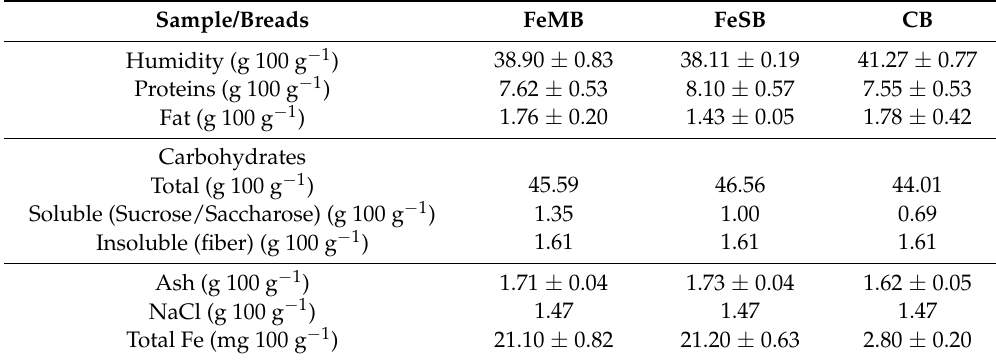
Table 3. Component analysis of breads administered to the pigs. All values are given in respect to the fresh bread mass. (FeMB: bread with microencapsulated iron; FeSB: bread with free iron; CB: control bread).